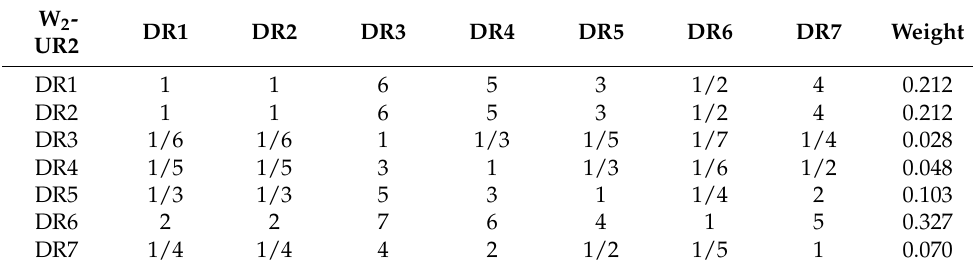
Table A1. Calculating relative weights of DRs in terms of UR2 through pairwise comparison to determine W2.